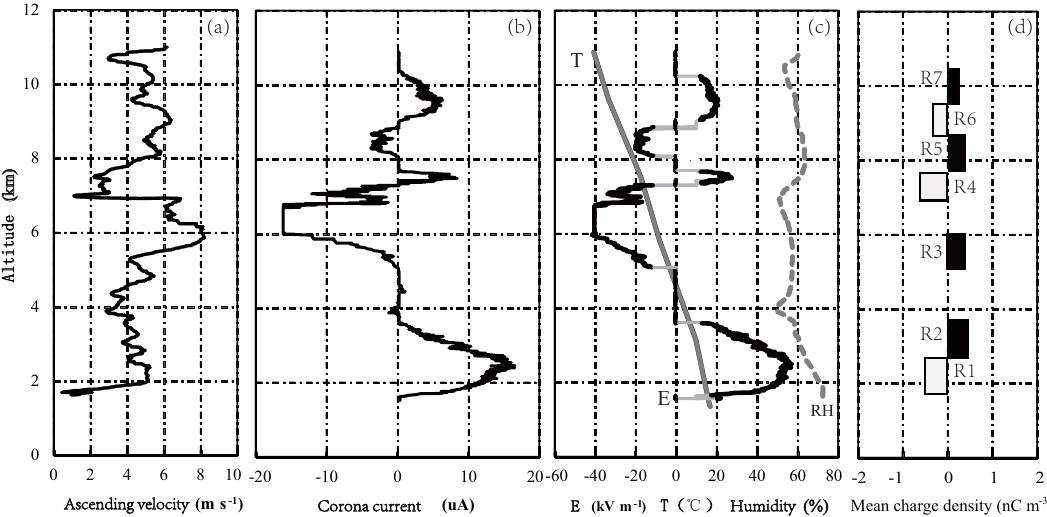
Figure 4. Sounding results: (a) ascending velocity of the balloon; (b) corona current; (c) E field, temperature (T), and relative humidity (RH). Black lines are vertical E fields retrieved by corona current and they have been manually connected by light grey lines to form a complete profile; (d) mean charge